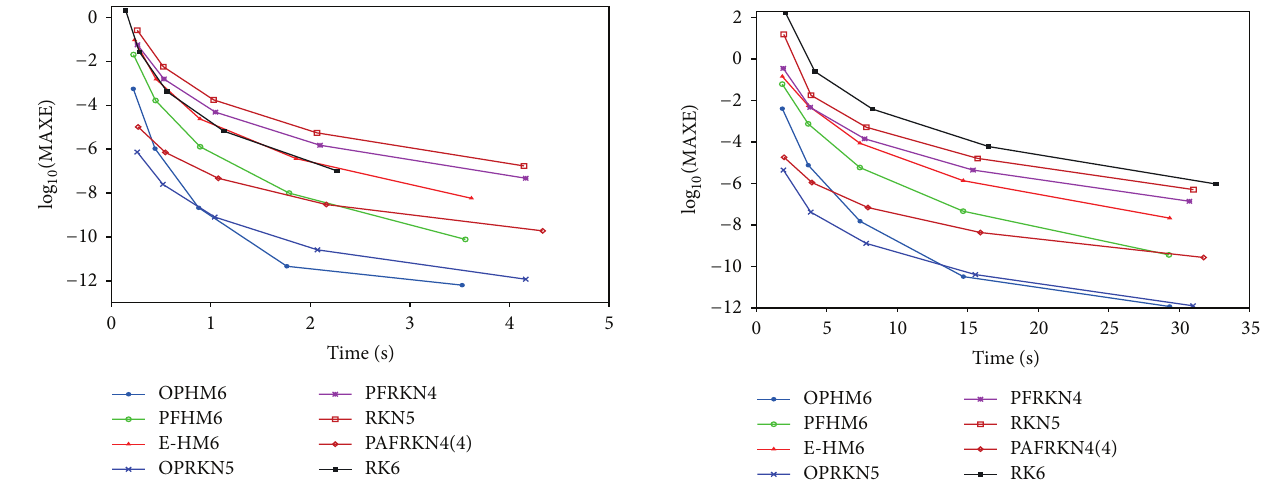
Figure 9: The efficiency curves of the optimized order six method and their comparisons for Problem 3 with 𝑡 0.125/2 𝑖 , 𝑖 = 1,...,5 .